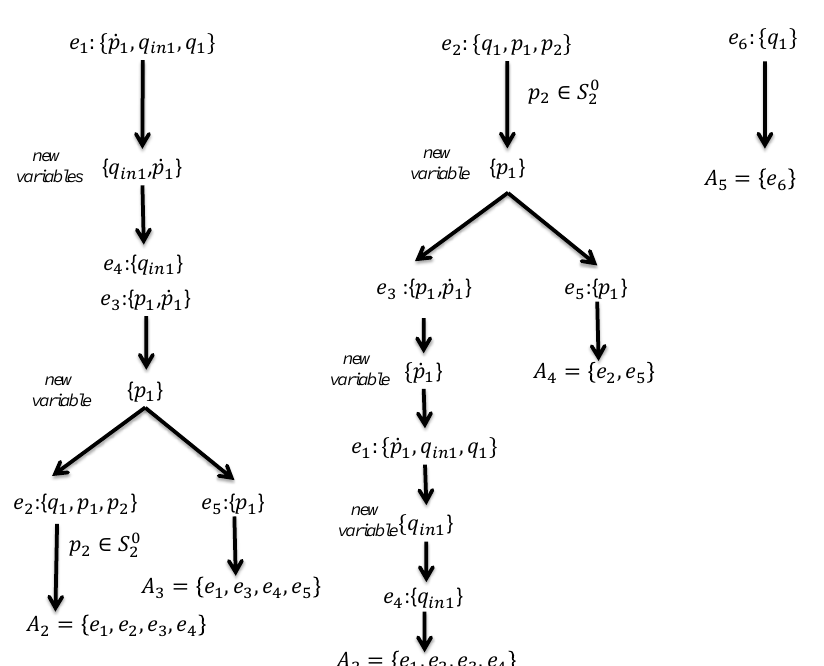
Figure 6. Finding the minimal sets of equations in S 1 to compute q 1